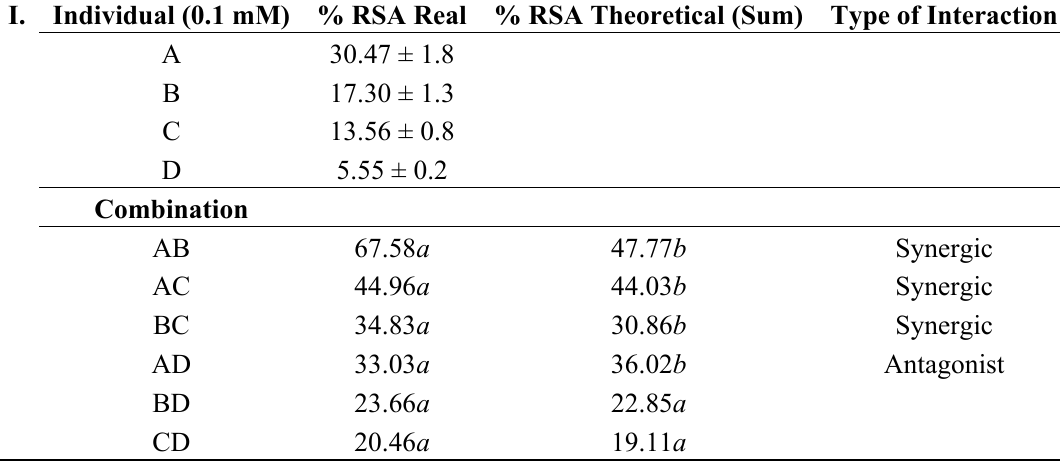
Table 1. Antioxidant capacity of mixtures containing two, three and four phenolic acids. ( A ) gallic acid, ( B ) protocatechuic acid, ( C ) chlorogenic acid, ( D ) vanillic acid. Different letter at each line indicates significant differences ( p ≤